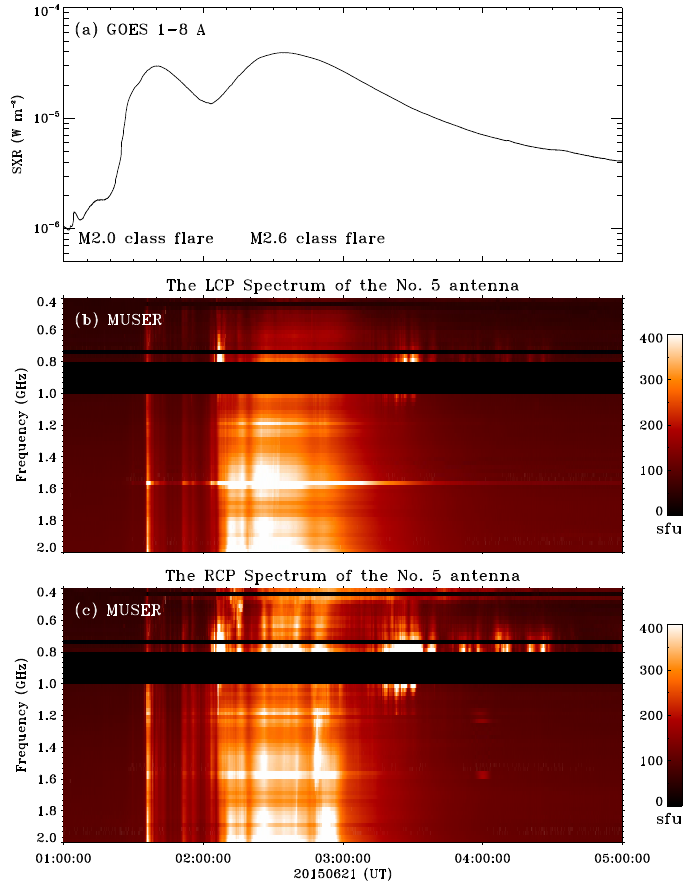
Figure 1. ( a ) The GOES SXR flux at 1–8 Å from 01:00 UT to 05:00 UT. ( b ) The LCP spectrum at 0.4–2 GHz observed by the No.5 antenna of MUSER-I. ( c ) The RCP spectrum at 0.4–2 GHz observed by the No.5 antenna of